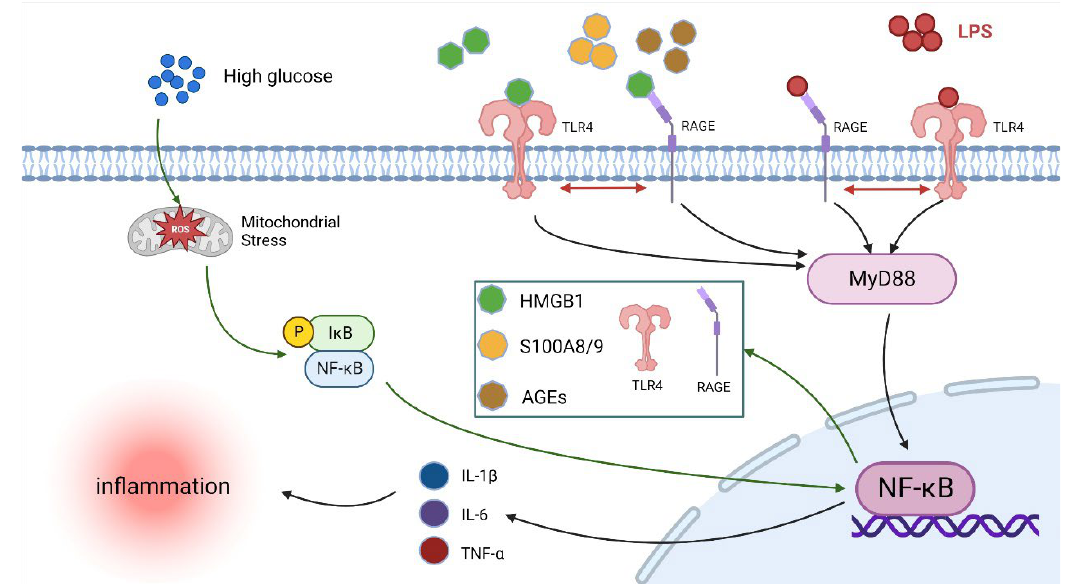
Figure 6. Schematic representation of the TLR4 – RAGE crosstalk participates in the HG - enhanced LPS - induced inflammation in BAMs (created with BioRender.com). HG firstly upregulated the levels of RAGE and TLR4 genes and protein expression in the BAM membrane and the secretion of pro - inflammatory - related mediators (such as HMGB1, S100A8/9, and AGEs) through the ROS/NF - κB pathway. Then , pro - inflammatory - related mediators bind to RAGE and TLR4, causing RAGE – TLR4 crosstalk (increasing the levels of RAGE and TLR4) to synergistically activate the downstream MyD88/NF - κB signaling pathway and promote the release of pro - inflammatory cytokines IL - 1β, IL - 6 , and TNF - α. When HG acts together with LPS, HG upregulates the levels of RAGE and TLR4 genes and protein expression, which can provide more receptor sites for LPS binding, and the LPS also upregulates the levels of RAGE and TLR4 genes and protein expression that can offer more receptor sites for pro - inflammatory - related mediators. The combination of HG and LPS through RAGE – TLR4 crosstalk further activates the downstream MyD88/NF - κB signaling pathway and exacerbates pro - inflammatory cytokine release in BAMs.